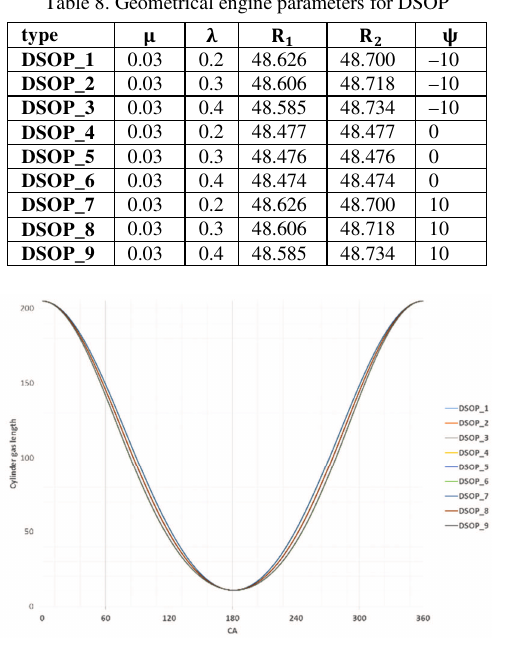
Fig. 14. DSOP piston motion curves